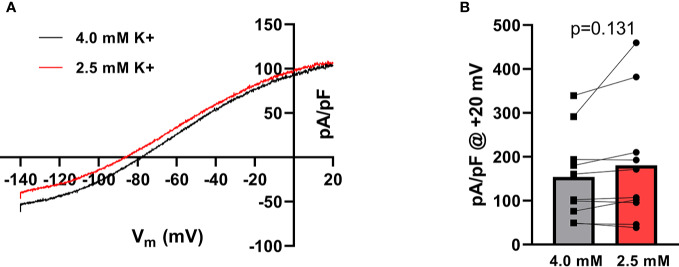
Hypokalemia shifts the reversal potential of K+ in HEK cells expressing KCa2.3. (A) Current–voltage relationship of KCa2.3 current measured at 4.0 mM extracellular K+ and at 2.5 mM K+. Currents were elicited by a voltage-ramp protocol from −140 to +20 mV (200 ms). (B) Summary graph showing the individual current levels at 2.5 mM and 4.0 mM K+, n = 10. Bars represent the mean values.